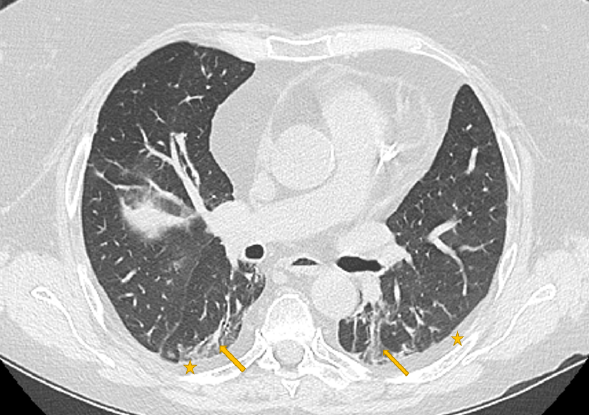
Figure 7. HRCT scan of a lung pneumonia. The imaging revealed lesions in the form of multiple confluent patchy areas of ground glass opacities seen scattered at both lungs (yellow arrows)— peripheral in distribution and bilateral minimal pleural effusion (yellow